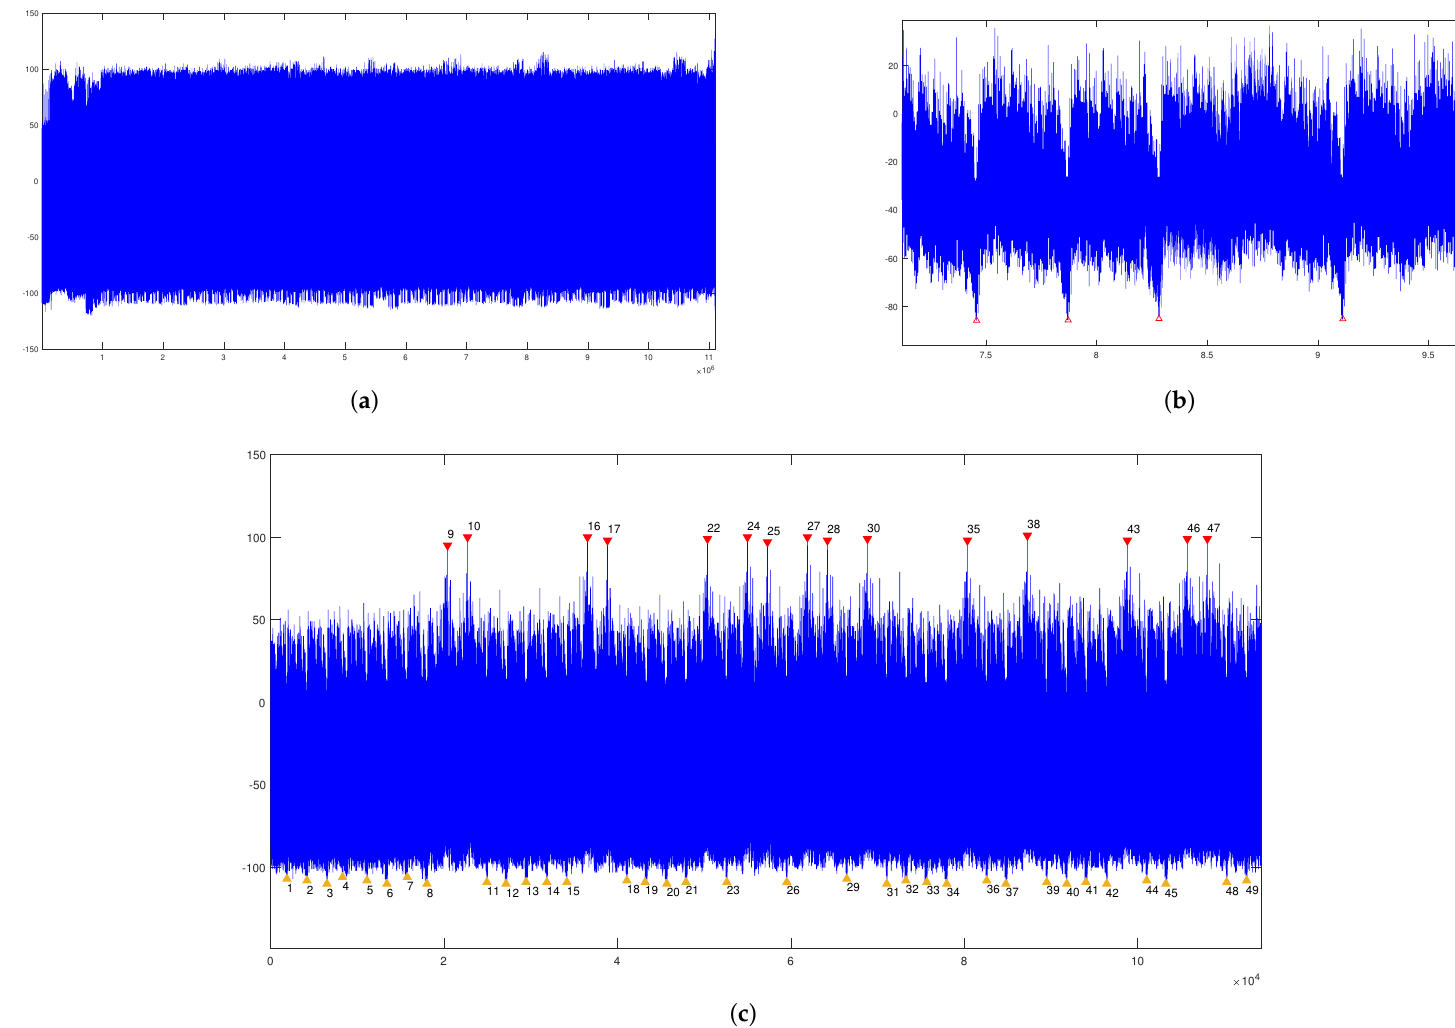
Figure 4. ( a ) Full trace of NTRUEncrypt; ( b ) Enlarged Low Peaks; ( c ) Result of SPA against f = pF +